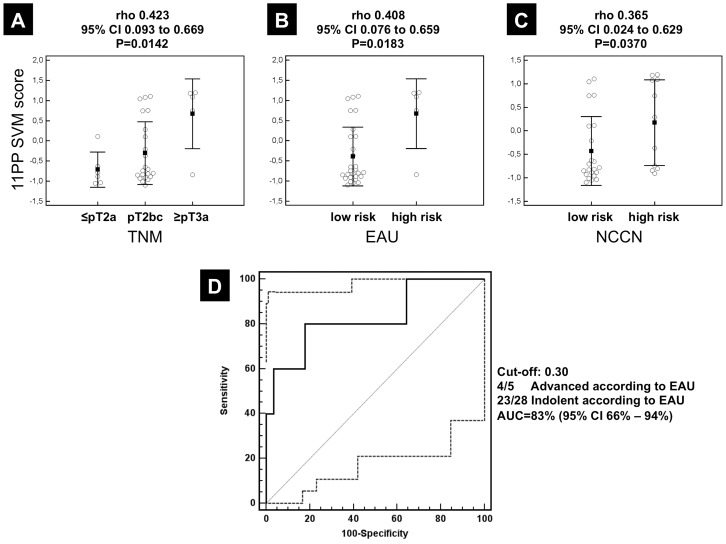
Biomarker performance validation.(A).Box and whisker plots of obtained 11PP results in the test cohort of PCa patients with GS 7 stratified according to TNM, (B) EAU, and (C) NCCN classification systems. Black squares indicate medians and whiskers 1.5-times the interquartile ranges. Rank correlation coefficients rho, the respective 95% CI and P-values are given above. (D) ROC curve (black lines) for 11PP classification of the independent validation cohort of PCa patients with GS 7 with either indolent (N = 28) or advanced (N = 5) disease according to EAU classification as reference standard. 95% confidence intervals are plotted as dashed lines. Diagonal line represents guessing probability with an area under the curve of 0.5. 95% confidence intervals (CI) are displayed as dashed lines.